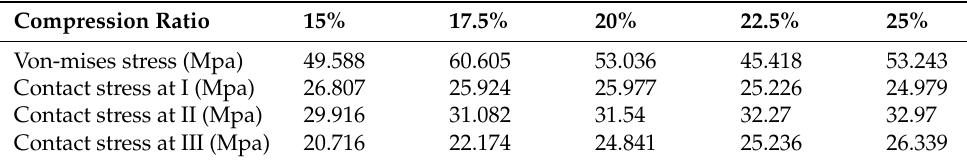
Table 5. Contact stress and compression ratio (working pressure 25